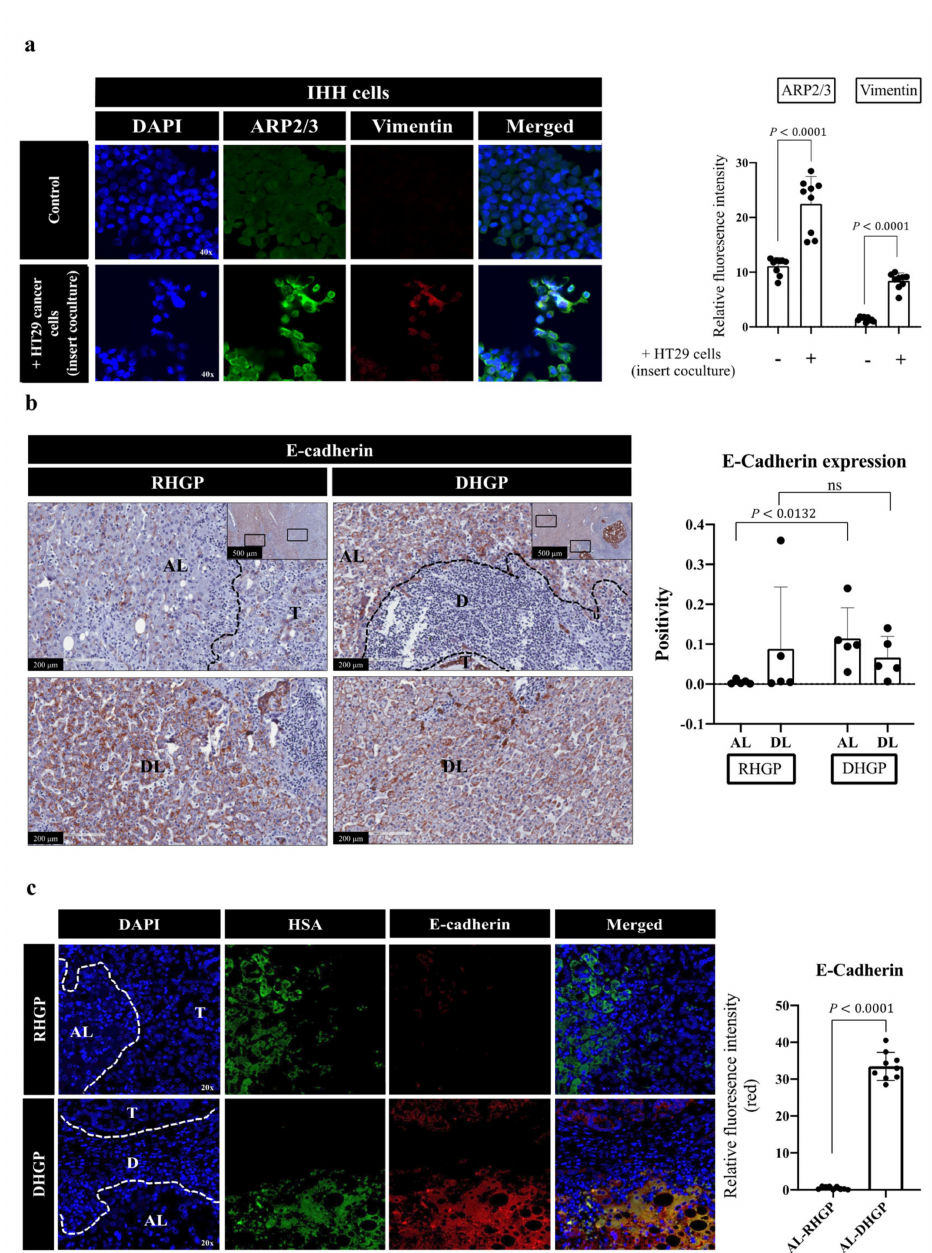
Figure 3. Expression of EMT biomarkers in hepatocytes in vitro and in vivo. ( a ) Representative images of coimmunostaining and colocalization overlay for IHH hepatocytes cocultured (insert coculturing) with HT29 cancer cell lines using motility marker, ARP2/3 (green), and EMT marker, vimentin (red). The right panel shows the quantification of positive pixels. Average pixel intensity was measured from three randomly selected areas for each sample. Results are representative of 3 independent experiments. ( b ) represents immunohistochemical staining for E-Cadherin on FFPE tissue sections of chemonaive CRCLM. The right panels represent quantification of staining positivity that was assessed in RHGP ( n = 5) and DHGP ( n = 5) lesions using Aperio software. ( c ) Represen- tative images of coimmunostaining for showing HSA (green) and E-Cadherin (red) on FFPE tissue sections of CRCLM resected from chemonaive patients. The right panels represent the quantifica- tion of positive pixels in CRCLM specimens, including RHGP ( n = 3) and DHGP ( n = 3). Average pixel intensity was measured from three randomly selected areas for each sample. AL—adjacent liver; D—desmoplastic ring; DL—distal liver; T—tumour. The bar chart shows mean values ± SD. ns = Not